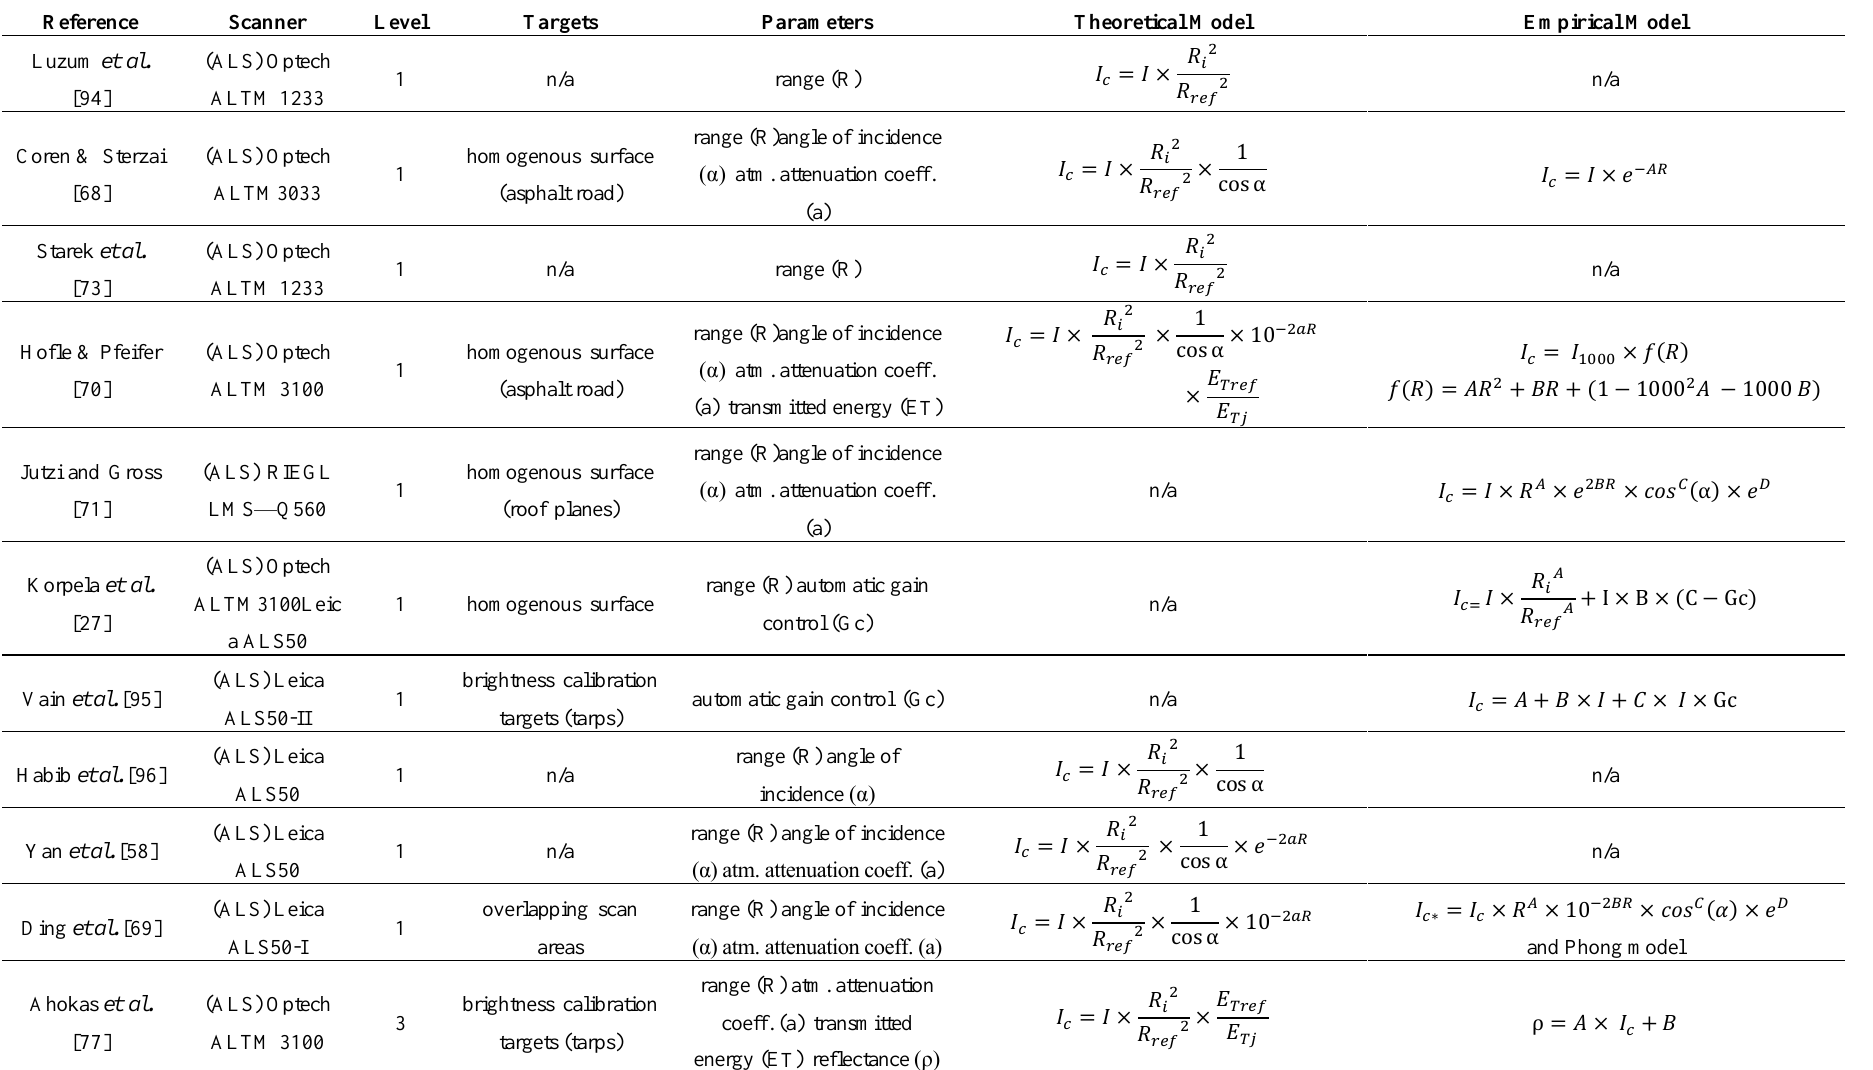
Table 4. Selected intensity correction and calibration methods (A, B, C, D denote empirical coefficients, ref denotes a